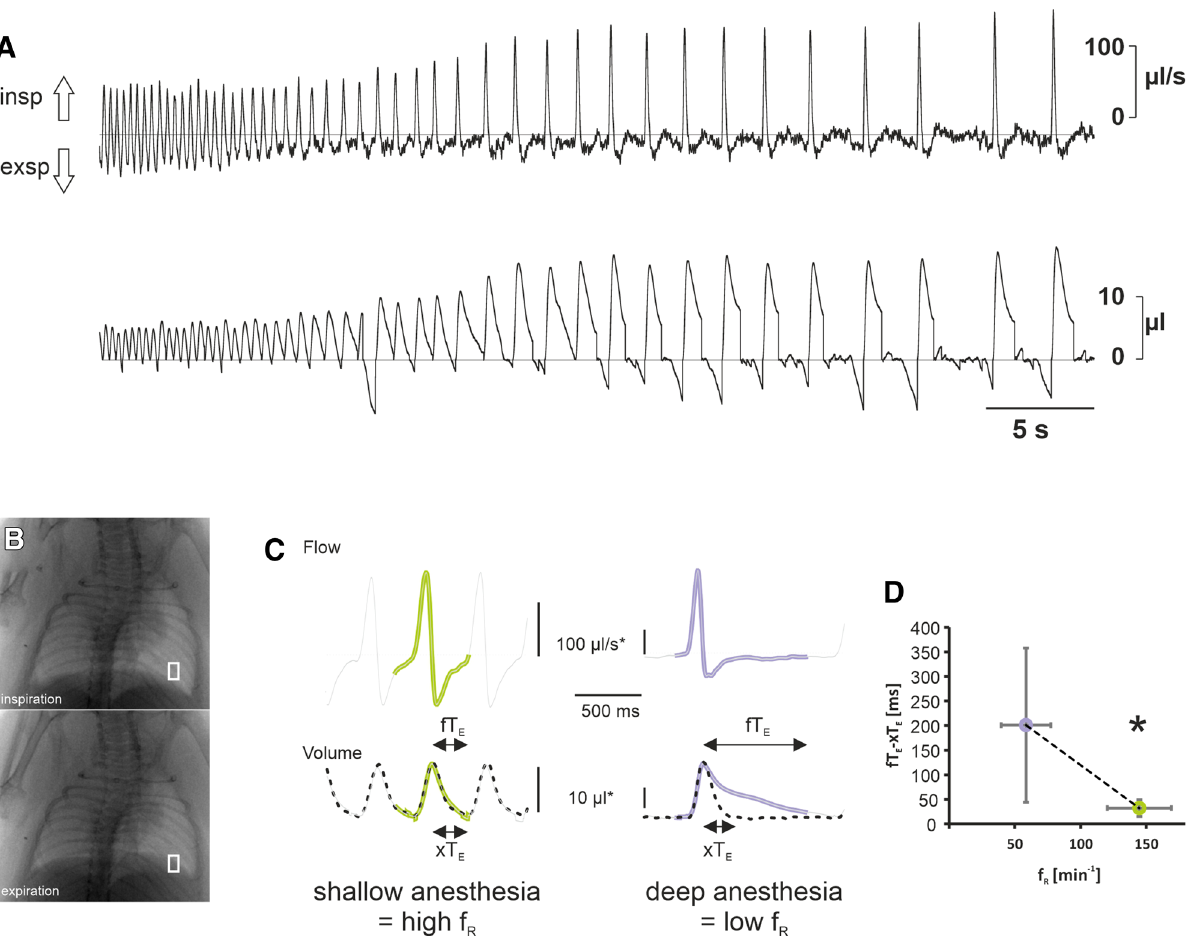
Figure 7. Effect of isoflurane on airflow, tidal volume and XLF-based lung transparence. ( A ) Flow whole- body plethysmography (FWBP) trace from an anesthetized mouse. Inspiratory concentration of isoflurane was increased shortly before the recording started. Upper trace shows the flow, while the lower trace shows the integral of the flow over time, which represents the volume (both parameters were not corrected for humidity and temperature; see methods). ( B ) Example of X-ray-based lung function (XLF) images taken in inspiration and expiration. ( C ) Comparison of XLF-based X-ray transmission (dotted line) and FWBP-based flow (upper trace) and volume changes (lower trace) during shallow (green) and deep anesthesia (purple). ( D ) Comparison of the arithmetic differences of the duration of expiratory (T E ) between FWBP (fT E ) and XLF (xT E ).